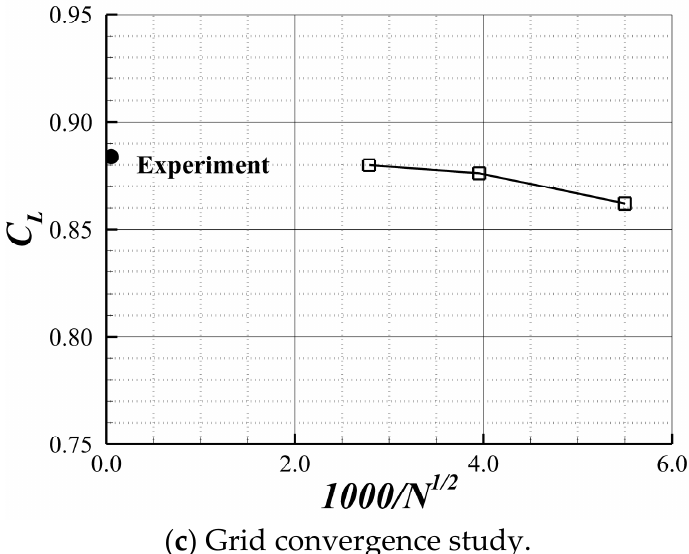
Figure 2. ( a ) The schematic diagram of the computational domain with boundary conditions, where r is the radius of the outer boundary in front of the airfoil, d 1 is the distance between the trailing edge of the airfoil and the left boundary and d 2 is the half width of the computational domain. ( b ) Fine grid of NACA64A010. ( c ) Grid convergence study at AOA = 11 ◦ , Re = 3 × 10 5 and Ma =